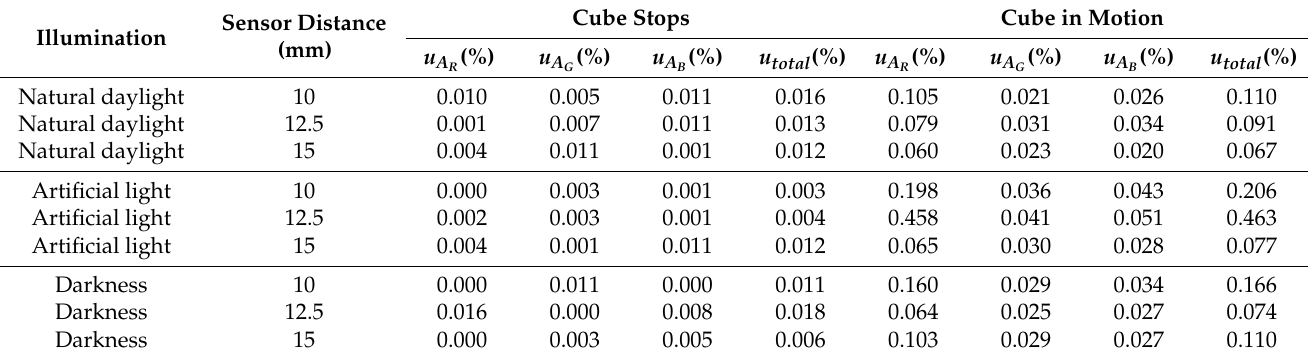
Table 4. Type A standard uncertainty for a red cube.